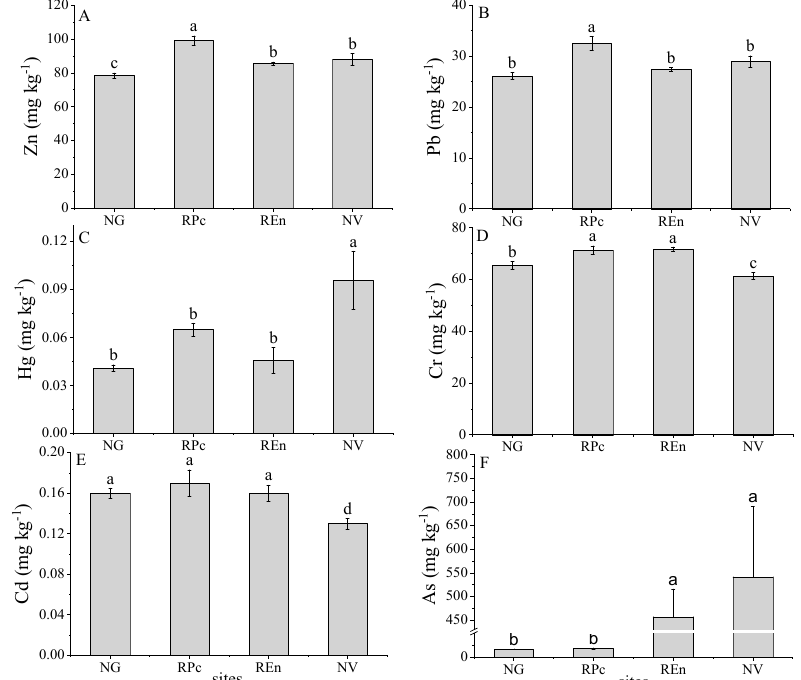
Figure 2. Concentrations of zinc (Zn) ( A ), lead (Pb) ( B ), mercury (Hg) ( C ), chromium (Cr) ( D ), cadmium (Cd) ( E ), arsenic (As) ( F ) in four sites. Di ff erent lowercase letters (a, b, c, d) indicate a significant di ff erence under di ff erent sites based on ANOVA ( p < 0.05). NG = native grassland, RPc = restoration by Picea crassifolia , REn = restoration by Elymus nutans , NV = non-vegetated.